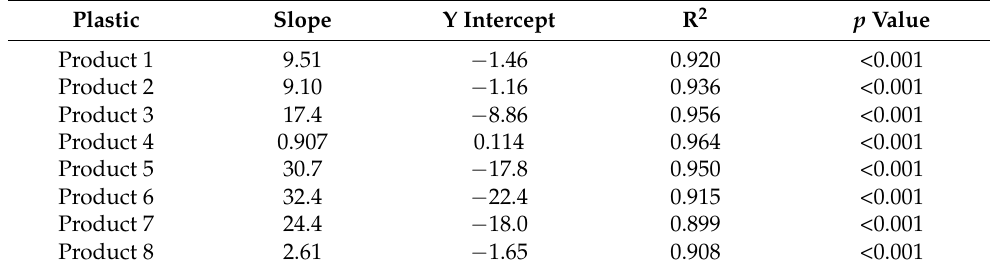
Table 5. Gradiation values of the initial phase of BMP curves based on the results of linear regression.